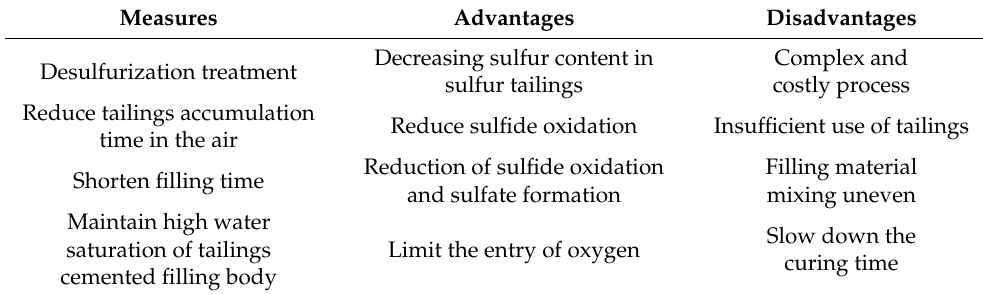
Table 2. Sulfide oxidation mitigation